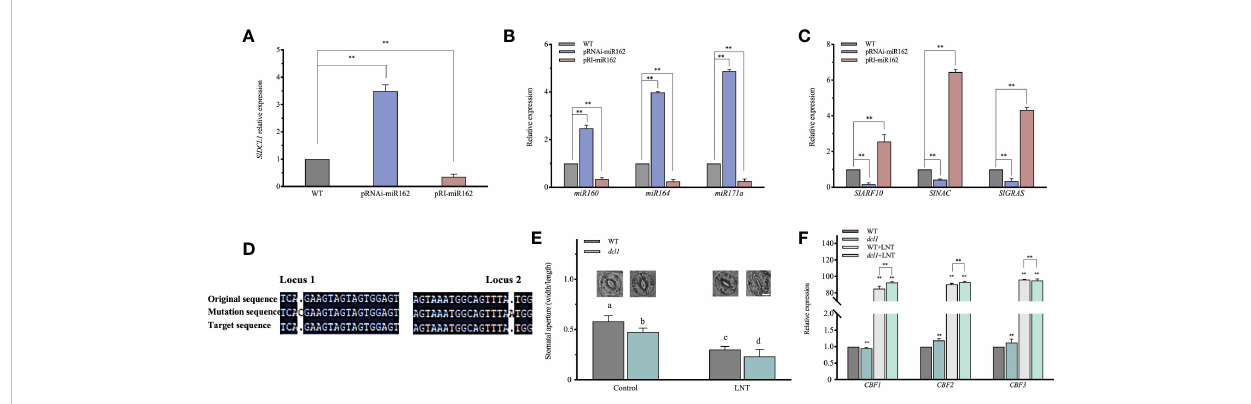
FIGURE 5 mIR162 regulated DCL1 cleavage and participated in the ABA signaling pathway in response to LNT stress. (A) DCL 1 expression in miR162 transgenic lines. (B) Expression analysis of DCL1-cleavable miRNAs ( miR160, miR164 , and miR171a ) in miR162 transgenic lines. (C) Expression analysis of target genes ( ARF10, NAC , and GRAS ) of DCL1-cleavable miRNAS in miR162 transgenic lines. (D) Monoclonal sequencing of SIDCL1 mutant identi fi cation ( dcl1-1-4/6/7 ). (E) Stomatal aperture and phenotype of dcl tomato plants under LNT stress. Data are mean and standard error of four independent experiments (n = 4) with at least 50 individual stomata measured for each replicate. Scale bar = 5 m m. (F) Expression analysis of ABA-dependent cold tolerance genes ( CBF1, CBF2 , and GBF3 ) in dcl tomato plants under LNT stress. Control: 25°C/15°C, LNT stress: 25°C/G°C (dayinight temperature). Data are mean and standard error of four independent experiments (n = 4). Lowercase letters indicat signi fi cant differences at P < 0.05 according fo Tukey's test. **P< 0.01 according o the test.